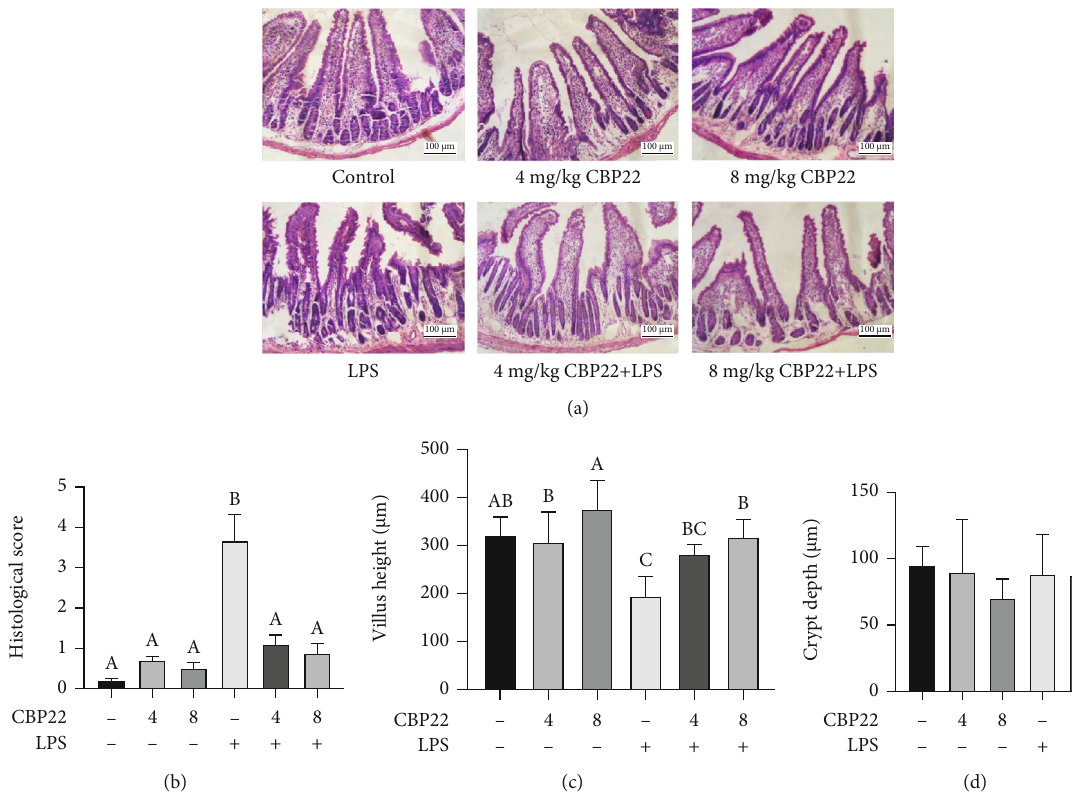
Figure 3: The protective e ff ects of CBP22 on jejunal morphology in mice treated with LPS. (a) H&E staining of the jejunal mucosa, scale bar = 100 μ m . (b) Mucosal damage grading. (c) Villus heights in the jejunum. (d) Crypt depths in the jejunum. The data are expressed as the mean ± SEM , n = 10 biological replicates; bars with di ff erent small capital letters are statistically di ff erent from one